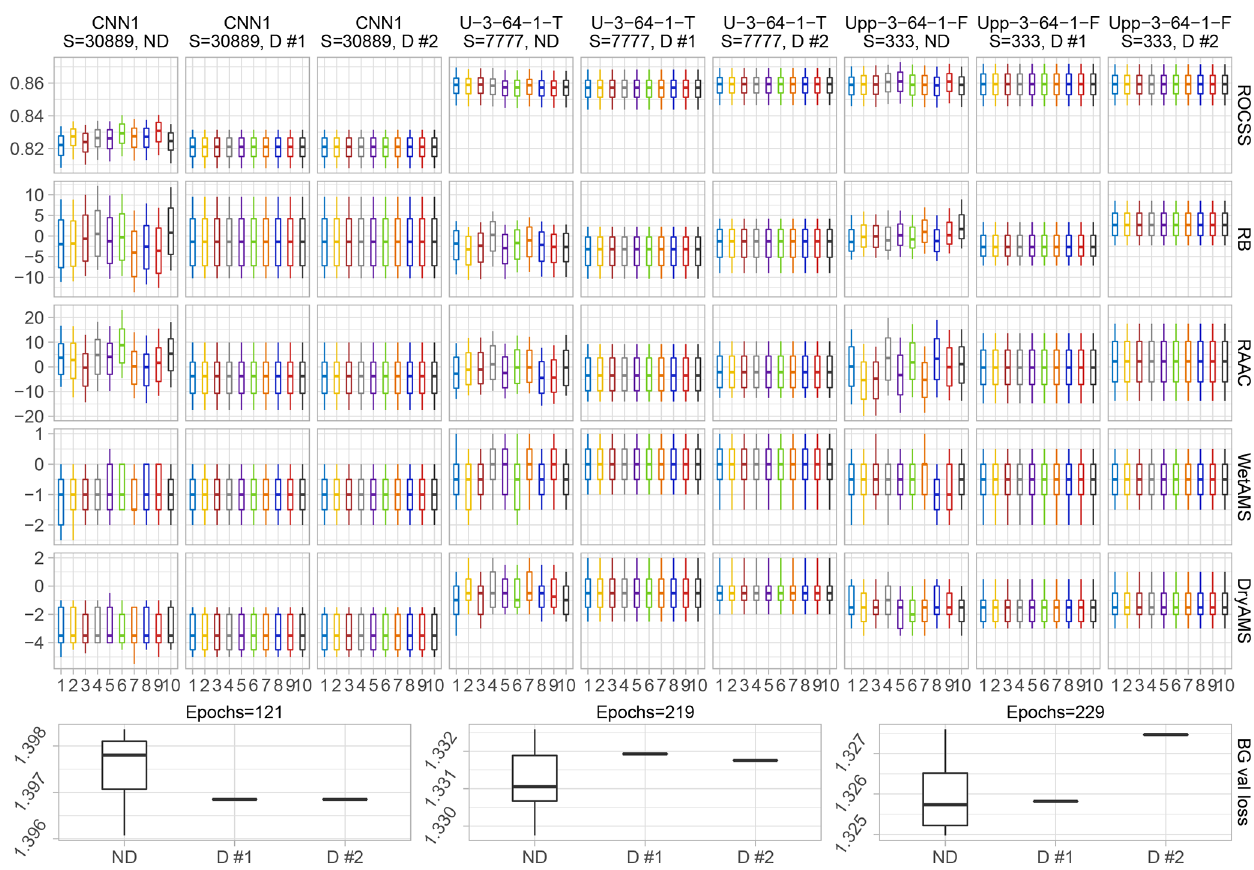
Figure 5. Comparison among 10 runs under the same seed number and configuration for the benchmark, and a sub-selection of the best performing transfer functions ordered column-wise. A sub-selection of the metrics from Table 1 is shown row-wise plus a row which depicts the boxplots of the minimum value achieved by the Bernoulli Gamma loss function (BG val loss) during training per type of run and model. D stands for deterministic and ND for non-deterministic runs. Note that all the runs per model needed the same amount of